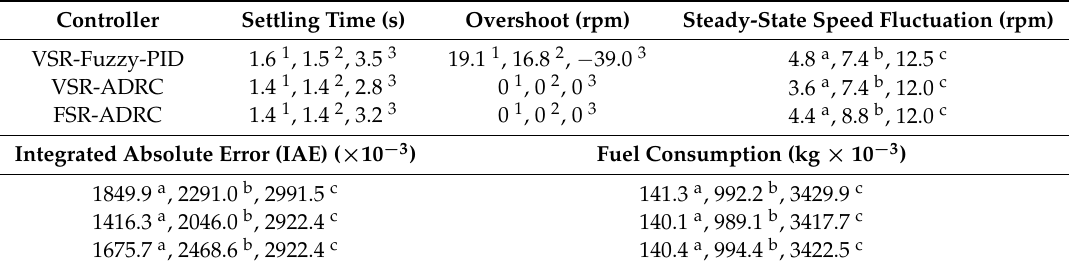
Table 1. The performance comparison of different criterions for the controllers during the speed tracking mode under standard engine model.